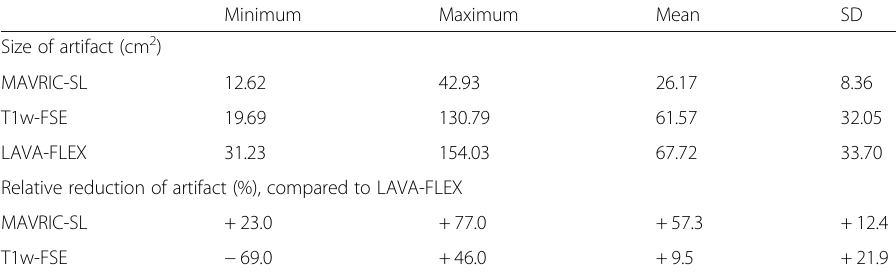
Table 3 Overview of artifact sizes in axial images in the tested sequences Minimum Maximum Mean SD Size of artifact (cm 2 ) MAVRIC-SL 12.62 42.93 26.17 8.36 T1w-FSE 19.69 130.79 61.57 32.05 LAVA-FLEX 31.23 154.03 67.72 33.70 Relative reduction of artifact (%), compared to LAVA-FLEX MAVRIC-SL + 23.0 + 77.0 + 57.3 + 12.4 T1w-FSE − 69.0 + 46.0 + 9.5 +